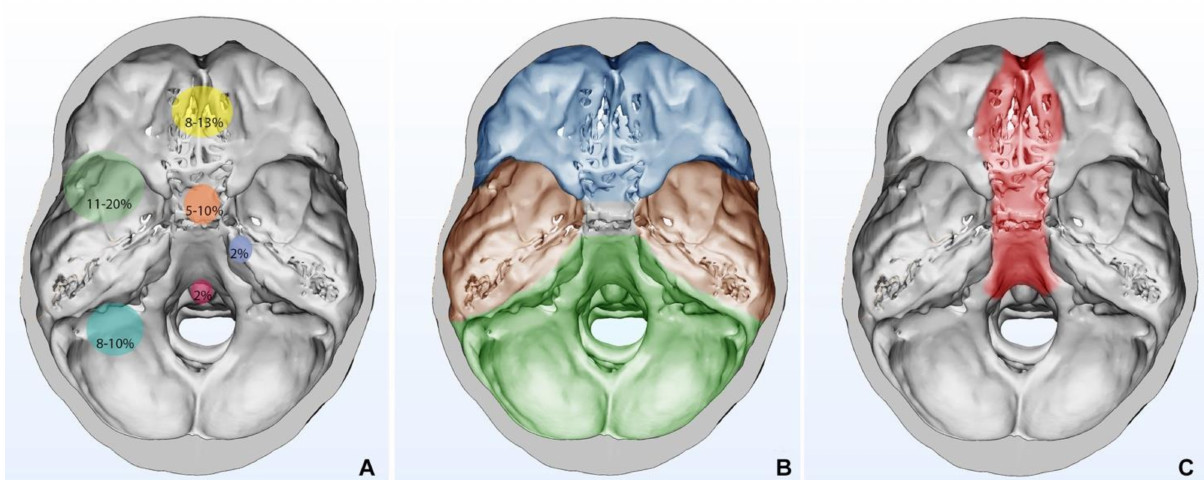
Figure 2. ( A ) Relative frequencies in SBM locations are stratified and shown with circles of progressively wider diameter; ( B ) Topological subdivision of skull base: anterior skull base is shown in blue, middle skull base is shown in brown, and posterior skull base is shown in green; ( C ) Anatomical area for which endoscopic endonasal approach can be